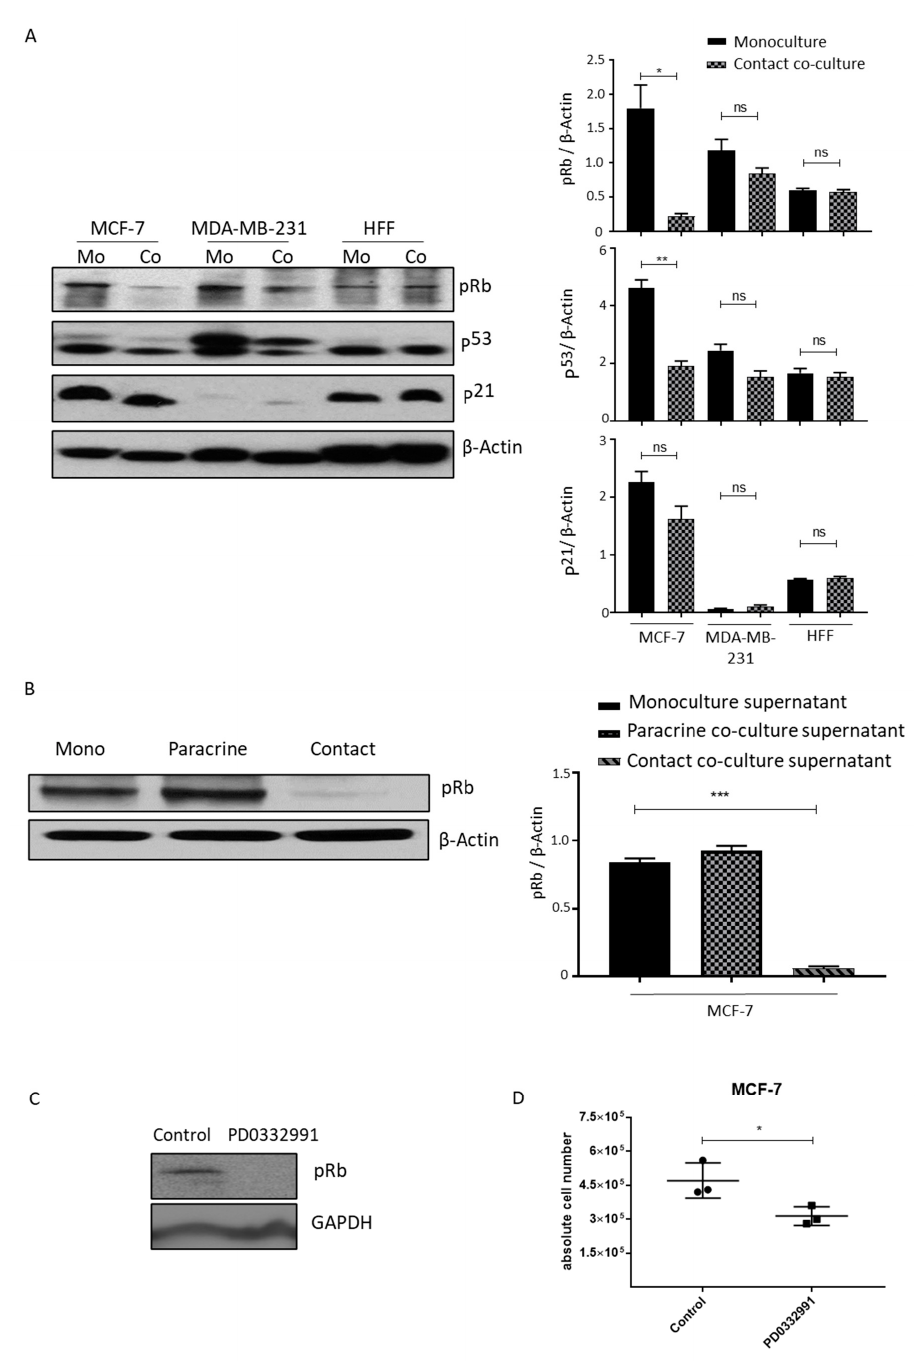
Figure 6. Contact lipoaspirate culture inhibits MCF-7 proliferation via the retinoblastoma-mediated pathway. ( A ) Cell lysates from MCF-7, MDA-MB-231 or HFF contact-co-cultured with lipo-aspirates were collected in Ripa lysate buffer. The phosphorylation of retinoblastoma protein (Rb) and the expression of p53 and p21 were analyzed by western blotting using specific antibodies. β -Actin was employed as the loading control. Fold changes in densitometric band intensities, acquired by image J and normalized to β -Actin, were compared and plotted. ( B ) Cell lysates from MCF-7 cells cultured in media from either monocultured, paracrine-cultured or contact-cultured MCF-cells with lipo-aspirates were collected in Ripa bu ff er and blotted for phosphorylated retinoblastoma protein (Rb). β -Actin was employed as the loading control. ( C , D ) MCF-7 cells were incubated with 10 µ M PD0332991 and cell lysates were blotted for Rb protein phosphorylation ( C ) and counted at day 4 post seeding ( D ). p value < 0.05 = *, p < 0.01 = **, p < 0.001 = ***, ns =